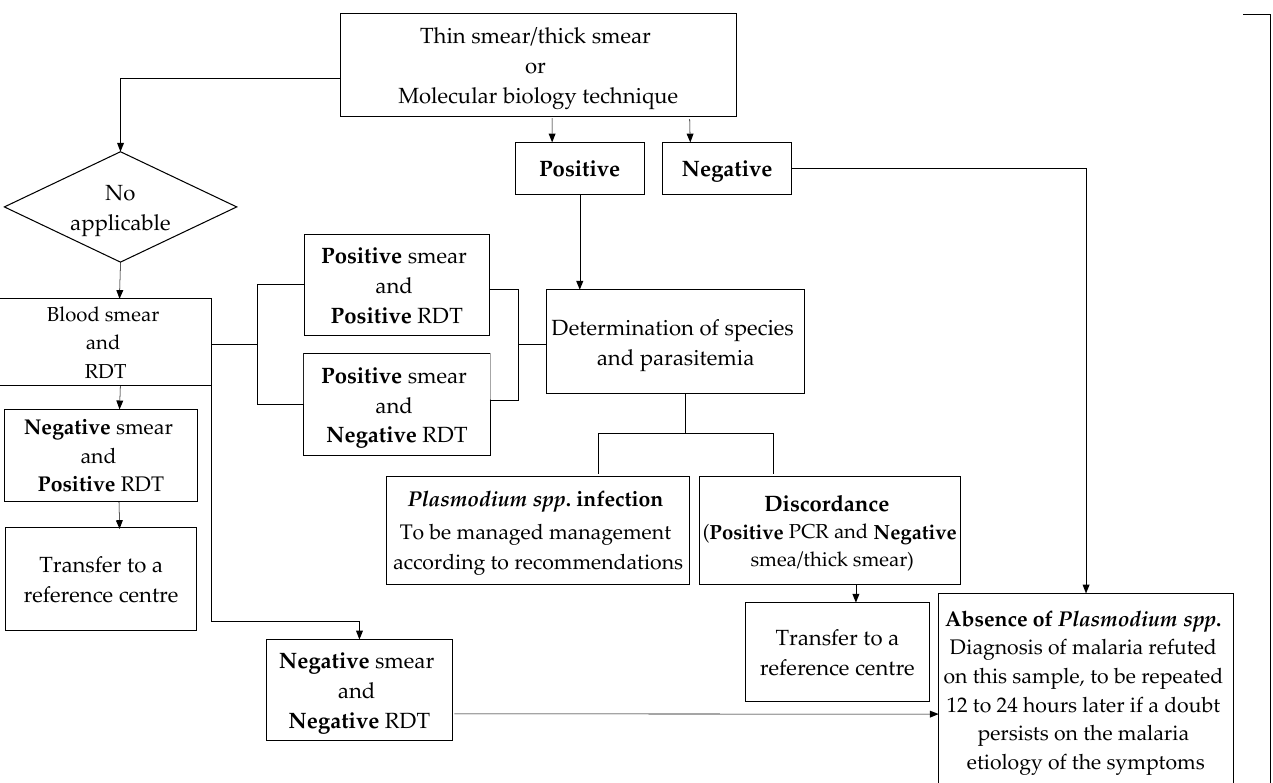
Figure 5. Flow chart showing the process of biological diagnosis of imported malaria [35].